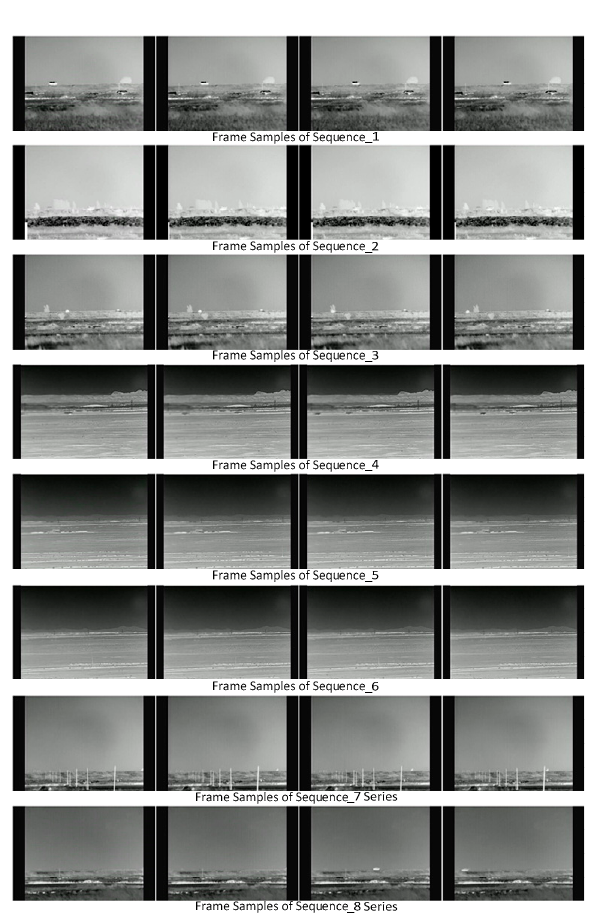
Figure 7. Frame samples in Remote Scene IR Dataset.